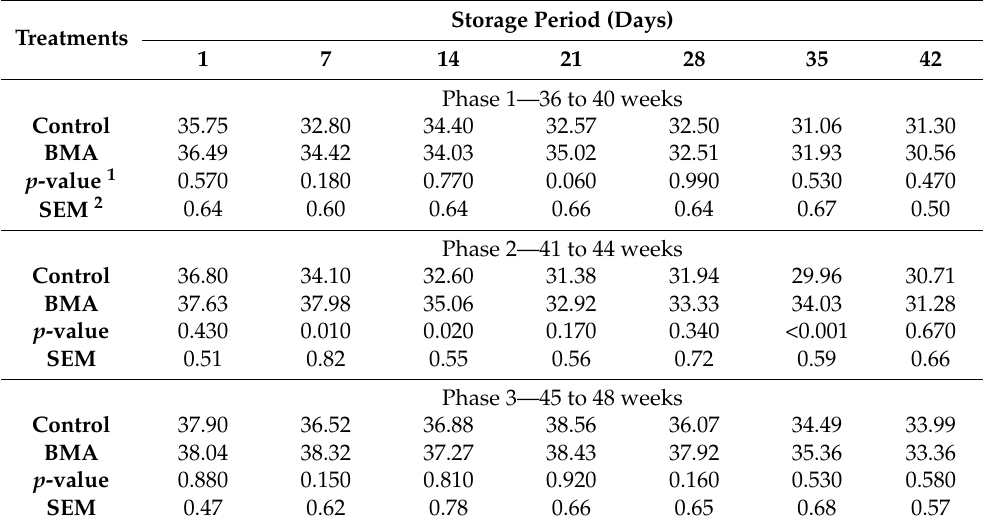
Table 2. Albumen weight (g) of eggs from laying hens fed with β -mannanase depending on stor- age time.